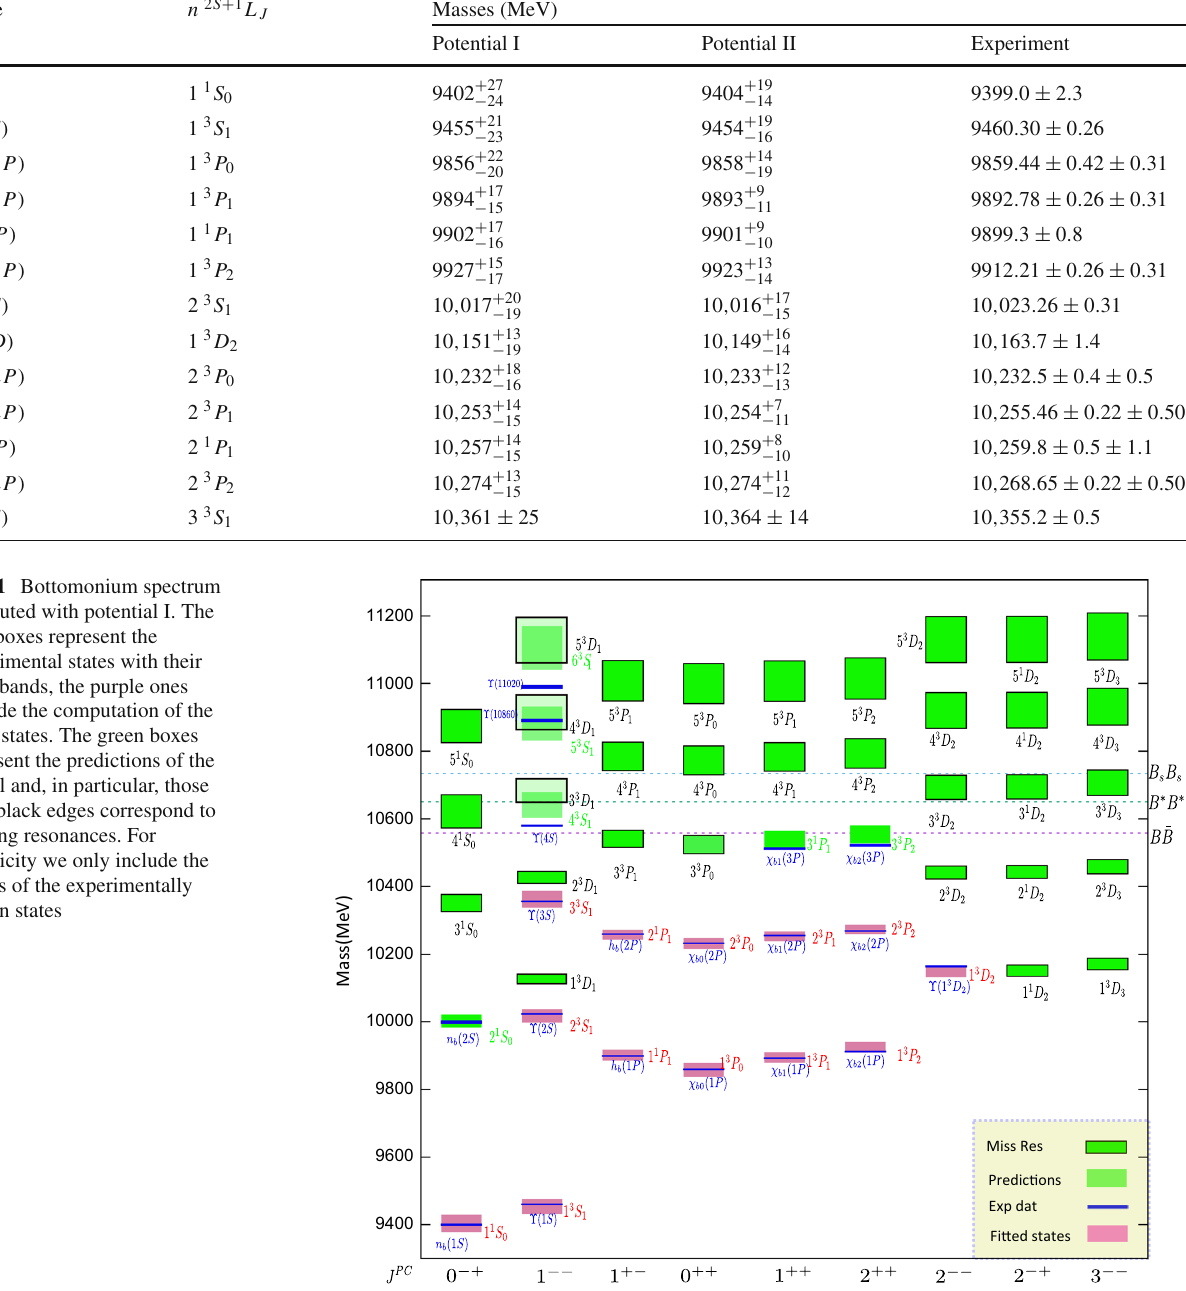
spin.Thestatisticalandsystematicerrorshavebeenaddedinquadrature for the bootstrap technique